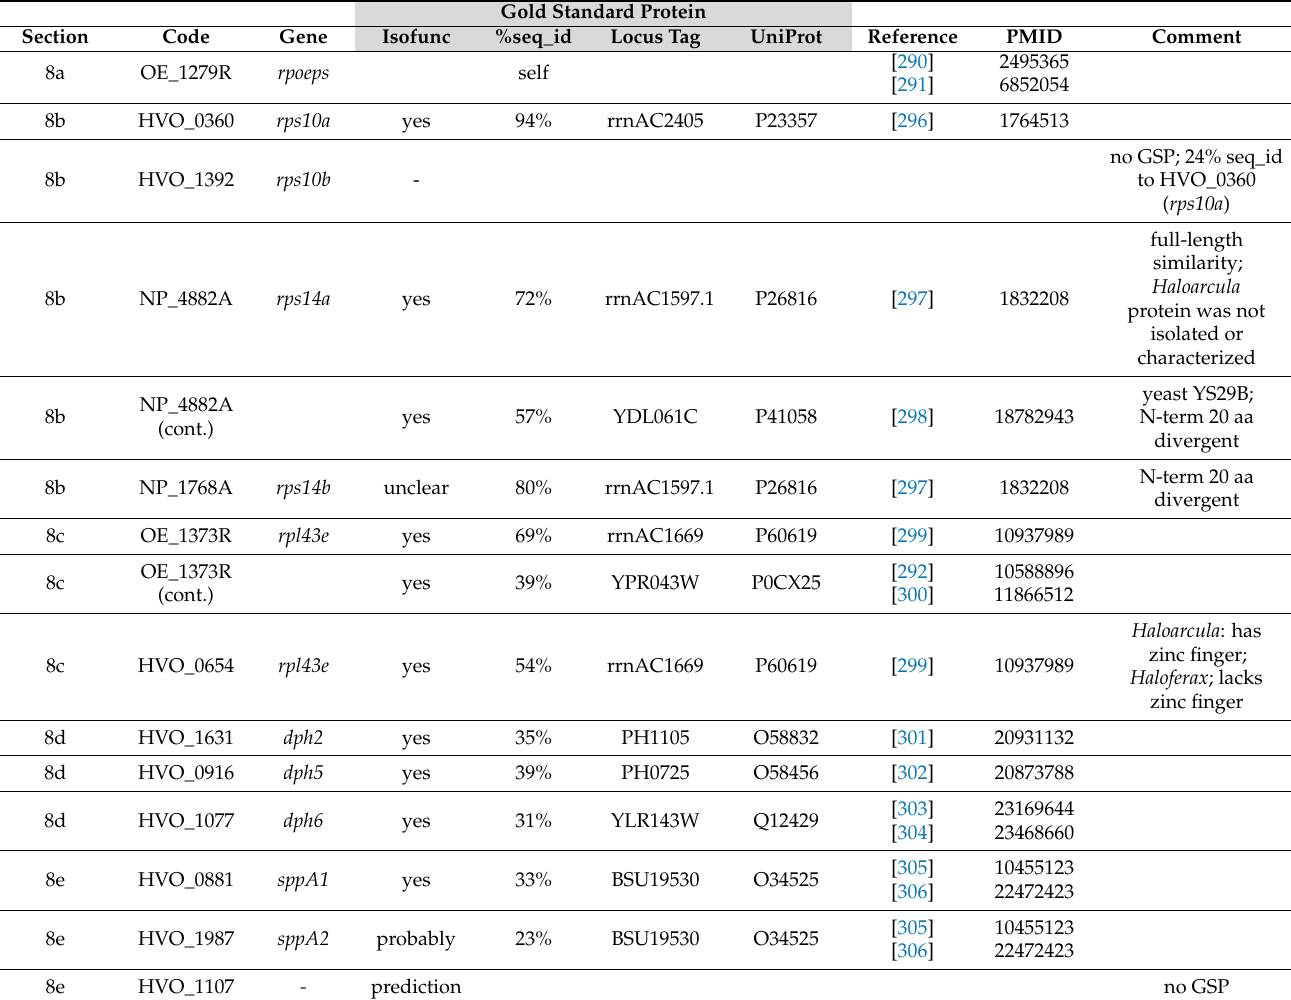
Table 8. Proteins with open annotation issues and their Gold Standard Protein homologs (Section 3.8). For a description of this table, see the legend to Table